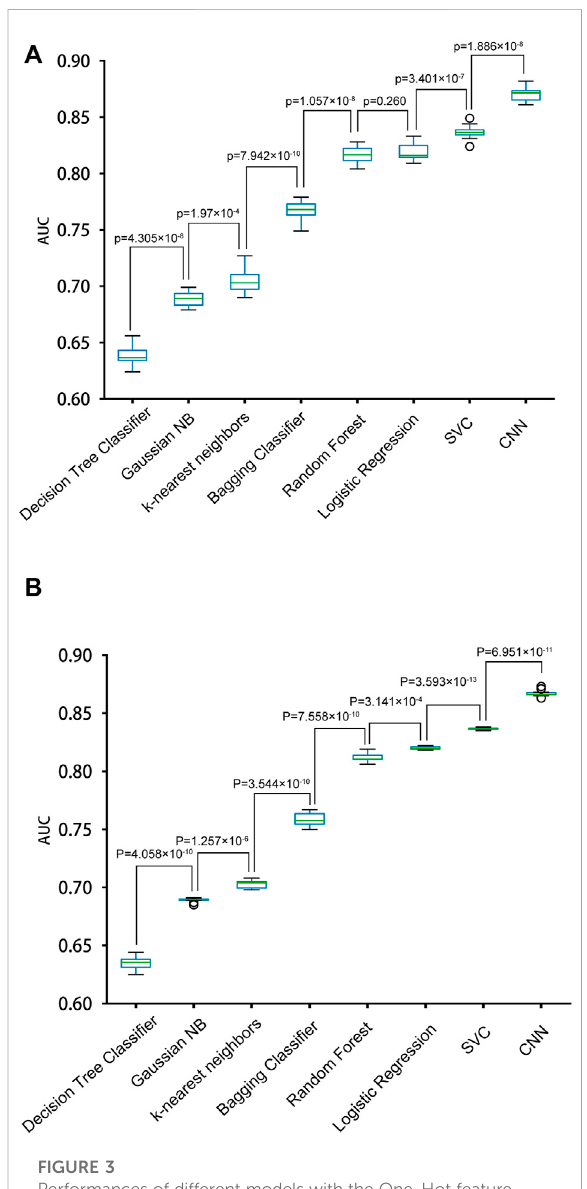
FIGURE 3 Performances of different models with the One-Hot feature for predicting PRme sites. (A) The AUC values of different models in ten-fold cross-validation. (B) The AUC values of different models in the independent